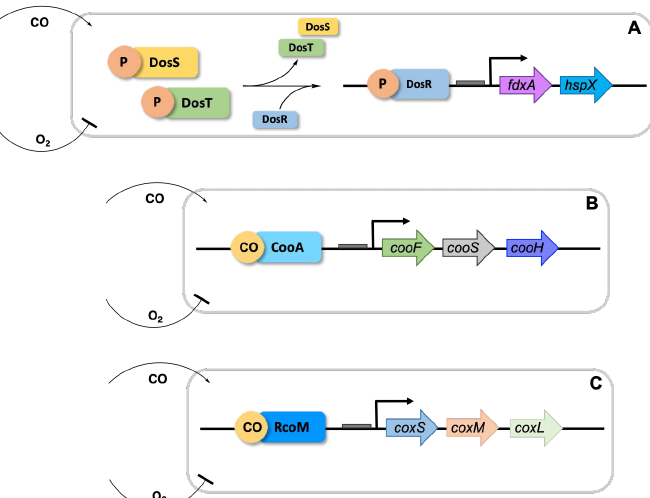
Figure 2. General scheme on the action of CO regulators. ( A ) Upregulation of the dormancy of DosR-phosphate transcriptional regulator is triggered by CO and H 2 S. ( B , C ) The CooA and RcoM regulators, which are activated by CO, upregulate the transcription of the coo and cox gene products that catalyze conversion of CO to CO 2